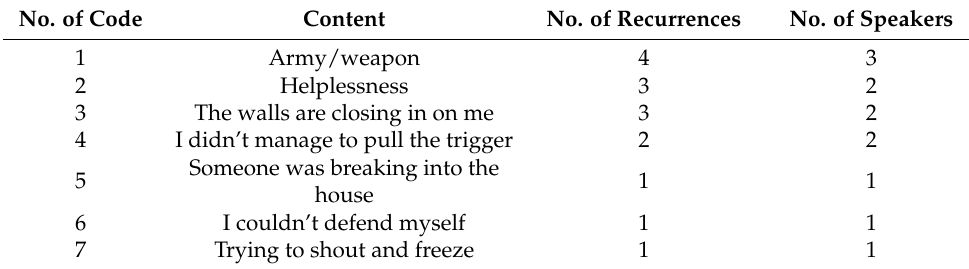
Table A4. Category D: Associations with personal dreams.